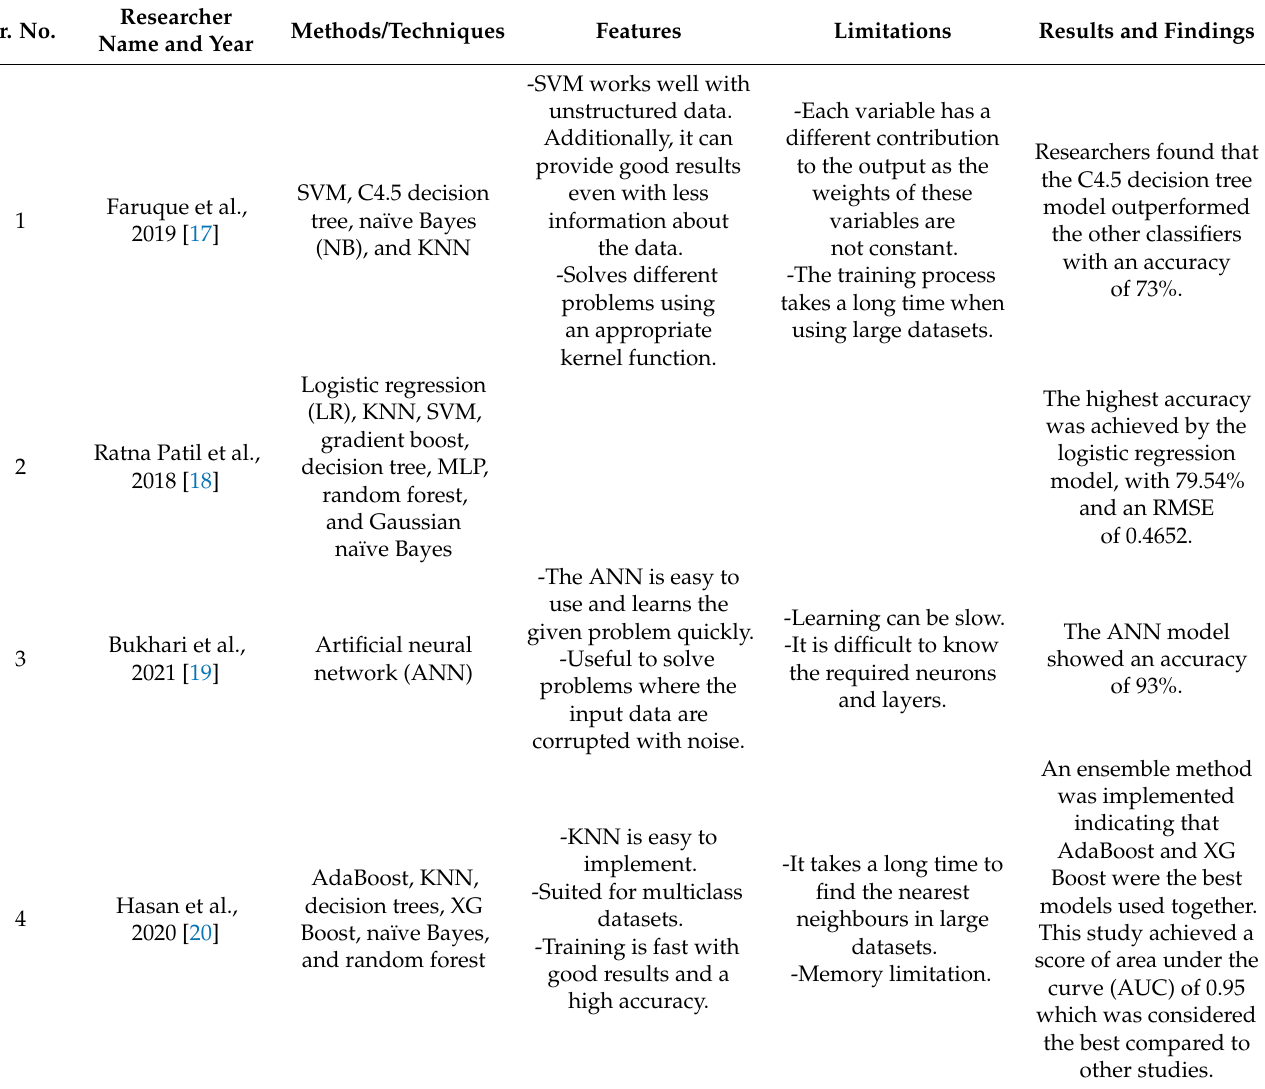
Table 1. Summary of machine learning classification techniques in diabetes